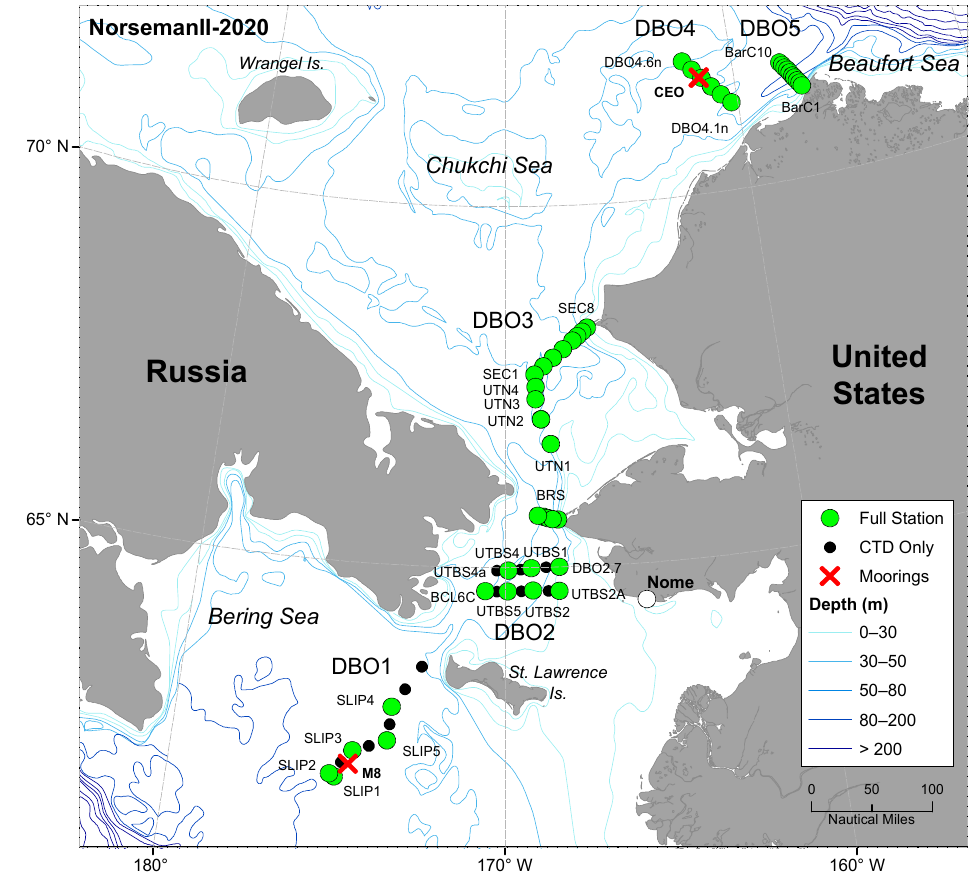
Figure 1. Distributed Biological Observatory station framework in the northern Bering and Chukchi seas.